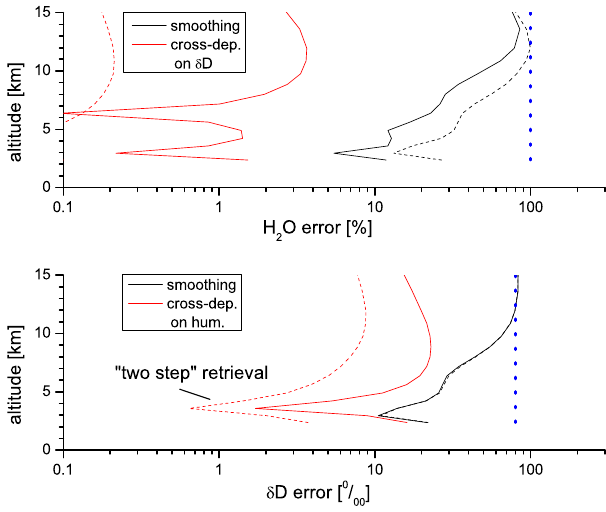
Fig. 4. Smoothing error and error due to cross-dependence (black and red lines, respectively) for Iza˜na. Top panel: H 2 O; bottom panel: δ D; solid lines: before applying the a posteriori operator C of Eq. (14); and dashed lines: after applying the operator C . The blue dashed line indicates the natural